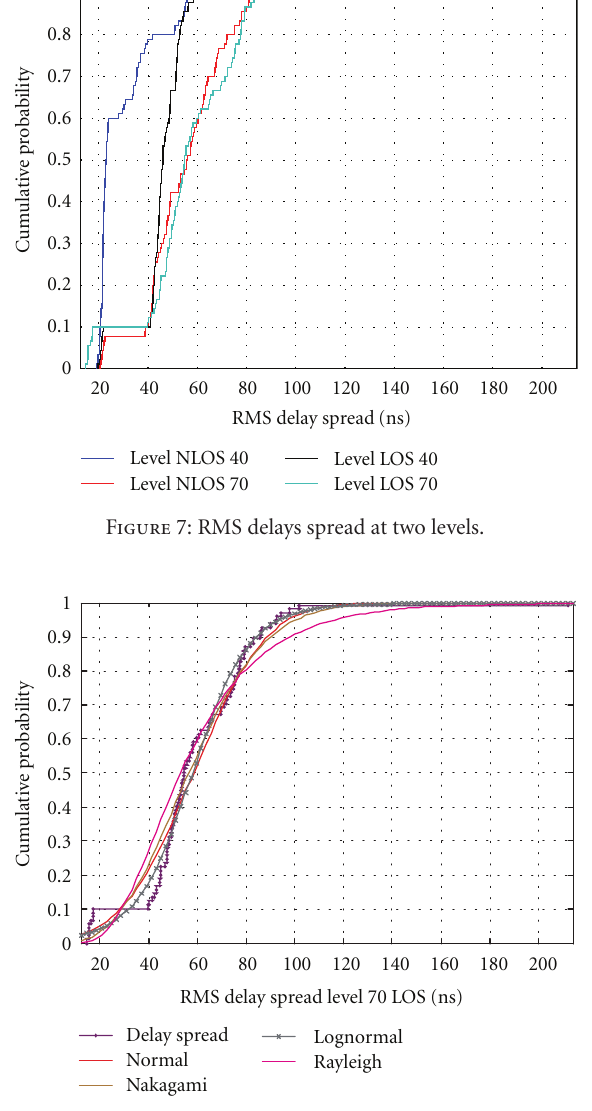
Figure 8: Cumulative distribution of RMS at level 70 (LOS). where M is the number of frequency-domain samples, | H ( f ) | is the measured frequency response of the channel, P is the transmitted power distributed on the frequency band, N 0 is a zero-mean white Gaussian noise power spectral density, and W is the bandwidth of the channel.